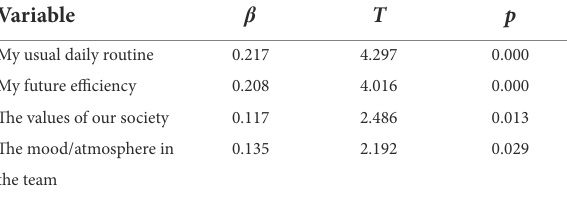
TABLE 5 Results of the multiple linear regression analysis with overall assessment of effects (single item) as dependent variable for the sample of participants who reported sick days (significant variables only, N =